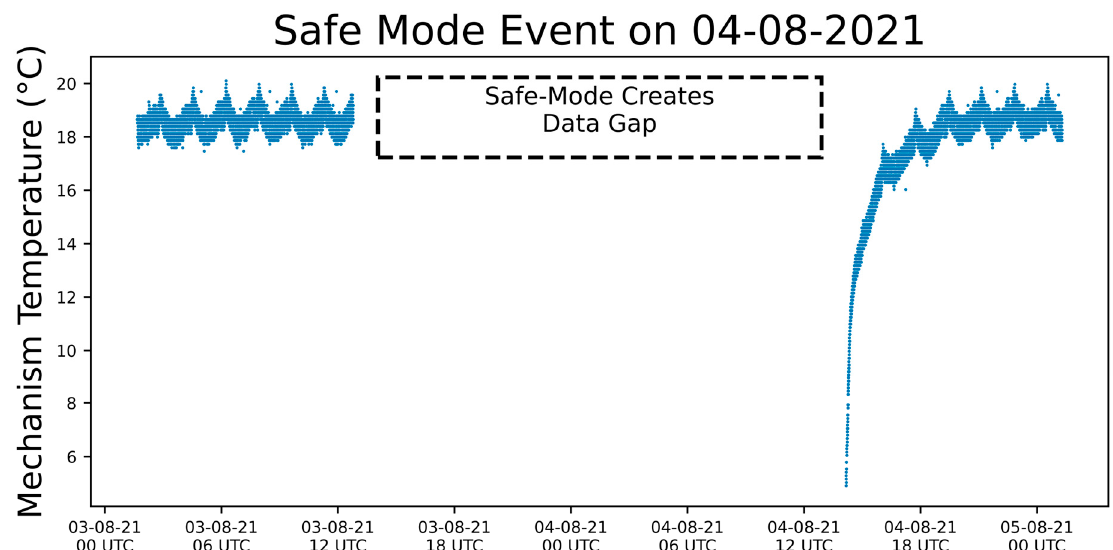
Figure 1. Time series of mechanism temperature during a safe mode event in August 2021. No valid data was collected when the instrument was in safe mode, resulting in a notable data gap. In addition, the mechanism temperature dropped tremendously during safe mode.